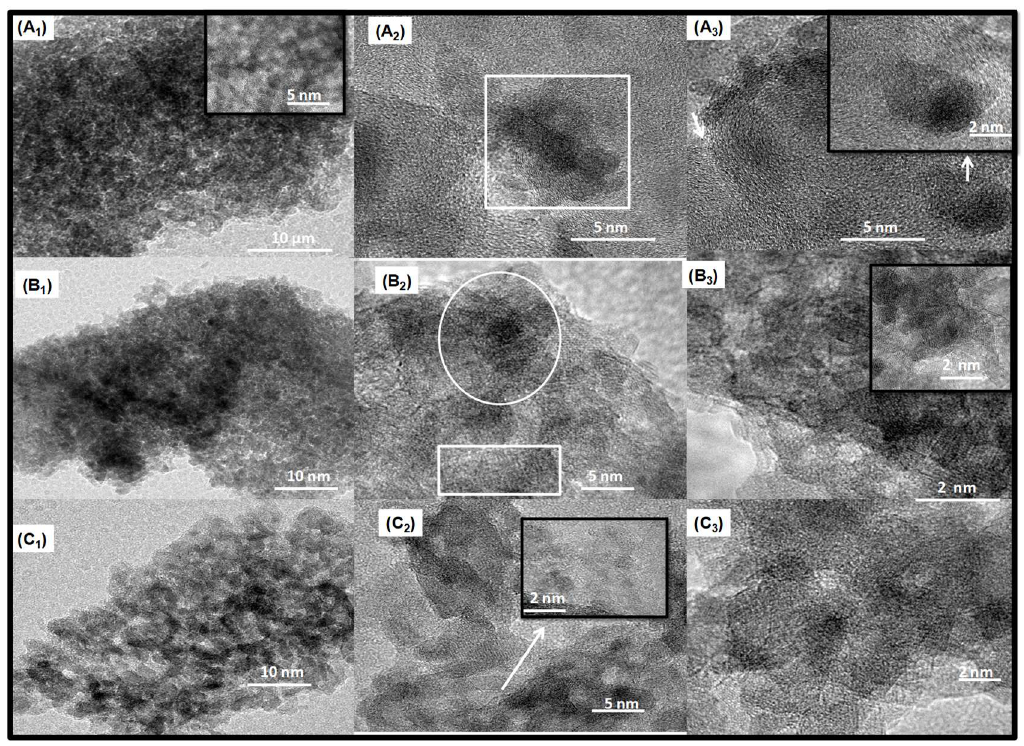
Figure 5. TEM images of the supports: ( A ) LA, ( B ) MA and ( C ) ZA samples. Insets illustrate parts of the figure at higher magnifications.